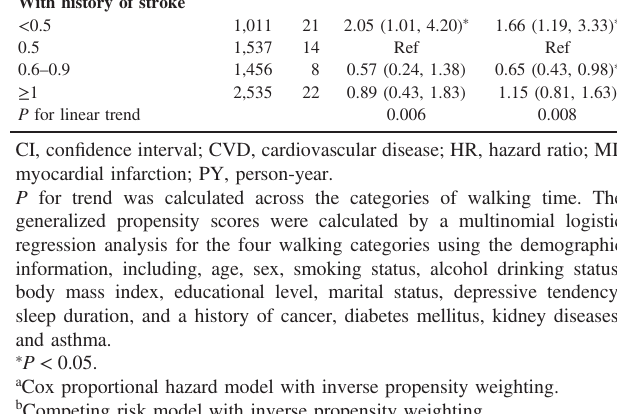
CI, con fi dence interval; CVD, cardiovascular disease; HR, hazard ratio; MI, myocardial infarction; PY, person-year. P for trend was calculated across the categories of walking time. The generalized propensity scores were calculated by a multinomial logistic regression analysis for the four walking categories using the demographic information, including, age, sex, smoking status, alcohol drinking status, body mass index, educational level, marital status, depressive tendency, sleep duration, and a history of cancer, diabetes mellitus, kidney diseases, and asthma. + P < 0.05.